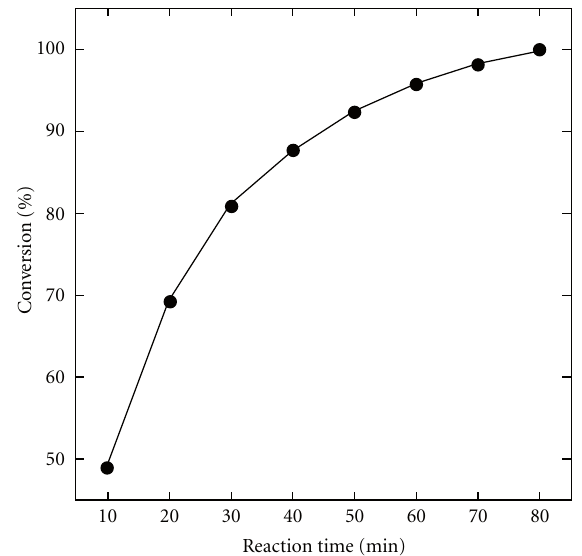
pounds—sustainable catalytic reactions with oxygen and without transition metals?” Angewandte Chemie , vol. 45,